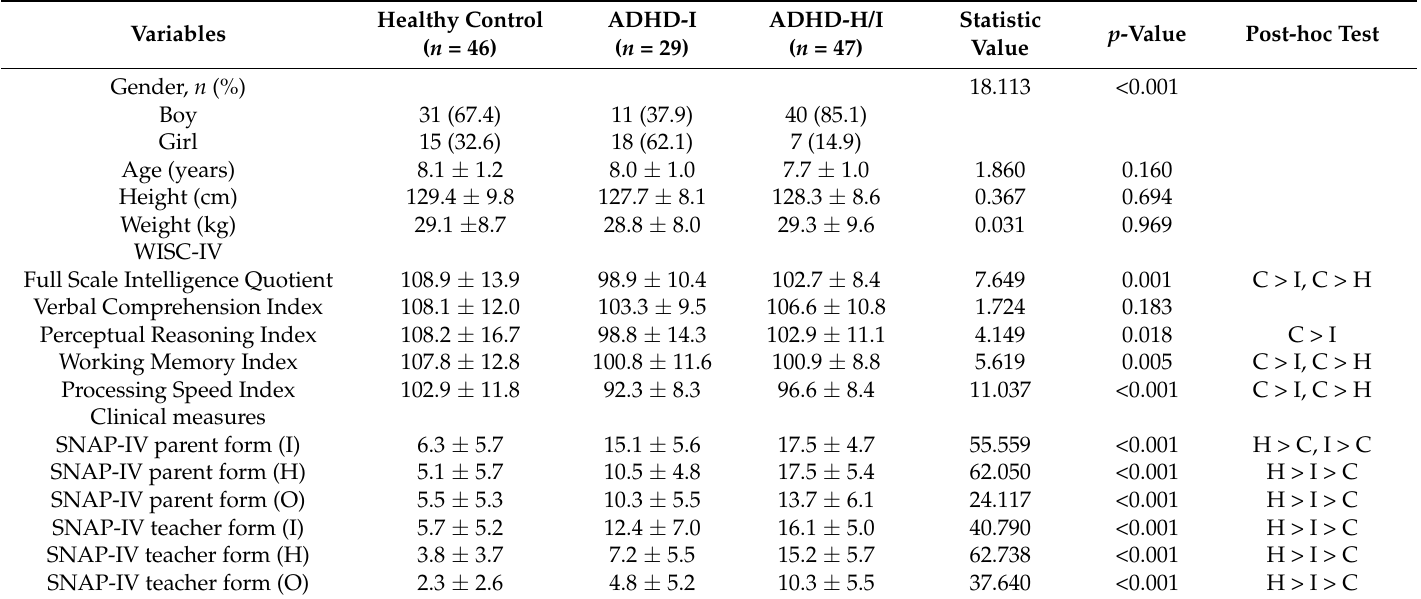
Table 1. Characteristics of the healthy control children, patients with attention deficit/hyperactivity disorder (ADHD) inattentive type (ADHD-I), patients with ADHD hyperactivity/impulsivity type